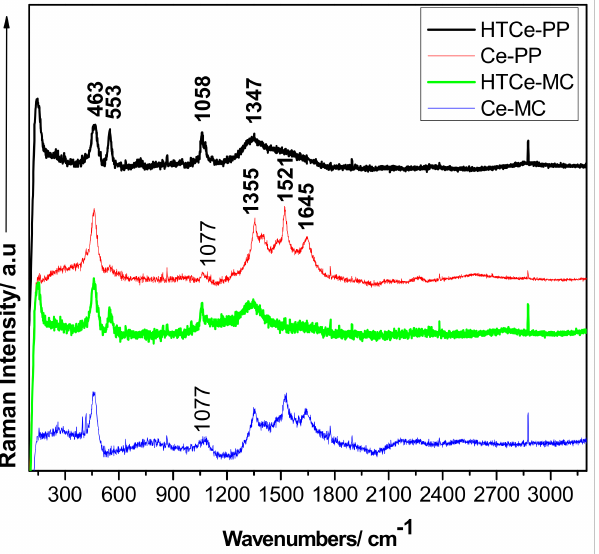
Figure 4. Raman spectra of the dried (HTCe-PP, HTCe-MC) and calcined (Ce-PP, Ce-MC) Ce- containing LDH